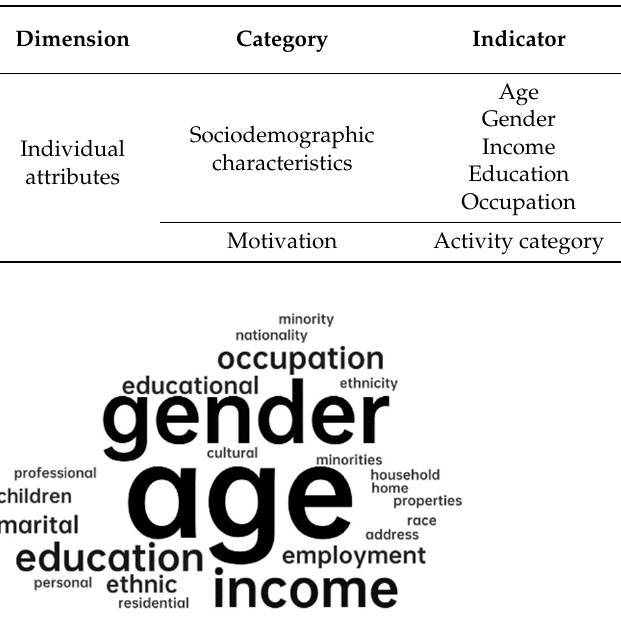
Table 7. Indicators of individual attributes.